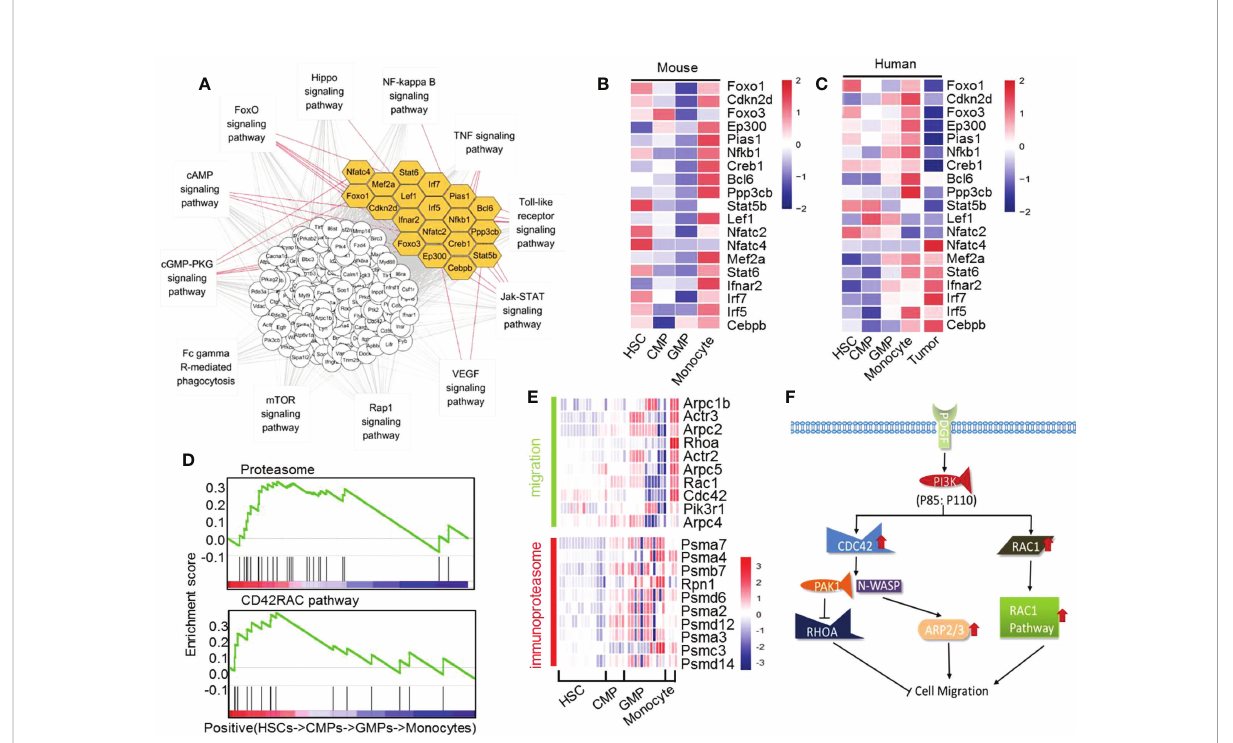
FIGURE 5 The signi fi cantly upregulated genes in mouse monocyte development. (A) Interaction network of the upregulated transcription factors and pathways in the differentiation of GMPs to monocytes. Yellow indicates the transcription factors. (B) Heatmap of the upregulated transcription factors during differentiation of GMPs into monocytes. (C) Heatmap of transcript factors changes in mouse and human HSCs into CMPs, CMPs into GMPs, and GMPs into monocytes, including human tumor differently expressed transcription factors. (D) GSEA quasi-time series analyses of genes related to CD42RAC pathway and proteasome pathway in HSCs, CMPs, GMPs, and monocytes. (E) Heatmap of migration-related genes and immunoproteasome-related genes during mouse monocyte development. (F) Proposed model of the PI3K, CDC42, and RAC1 pathways related to the cell migration during monocyte